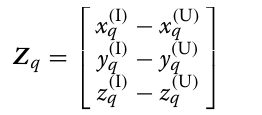
Fig. 8 The localization errors measured by the FIR FIR predictive mode, and the FIR + data missing region: a east direction, b north direction, c up direction